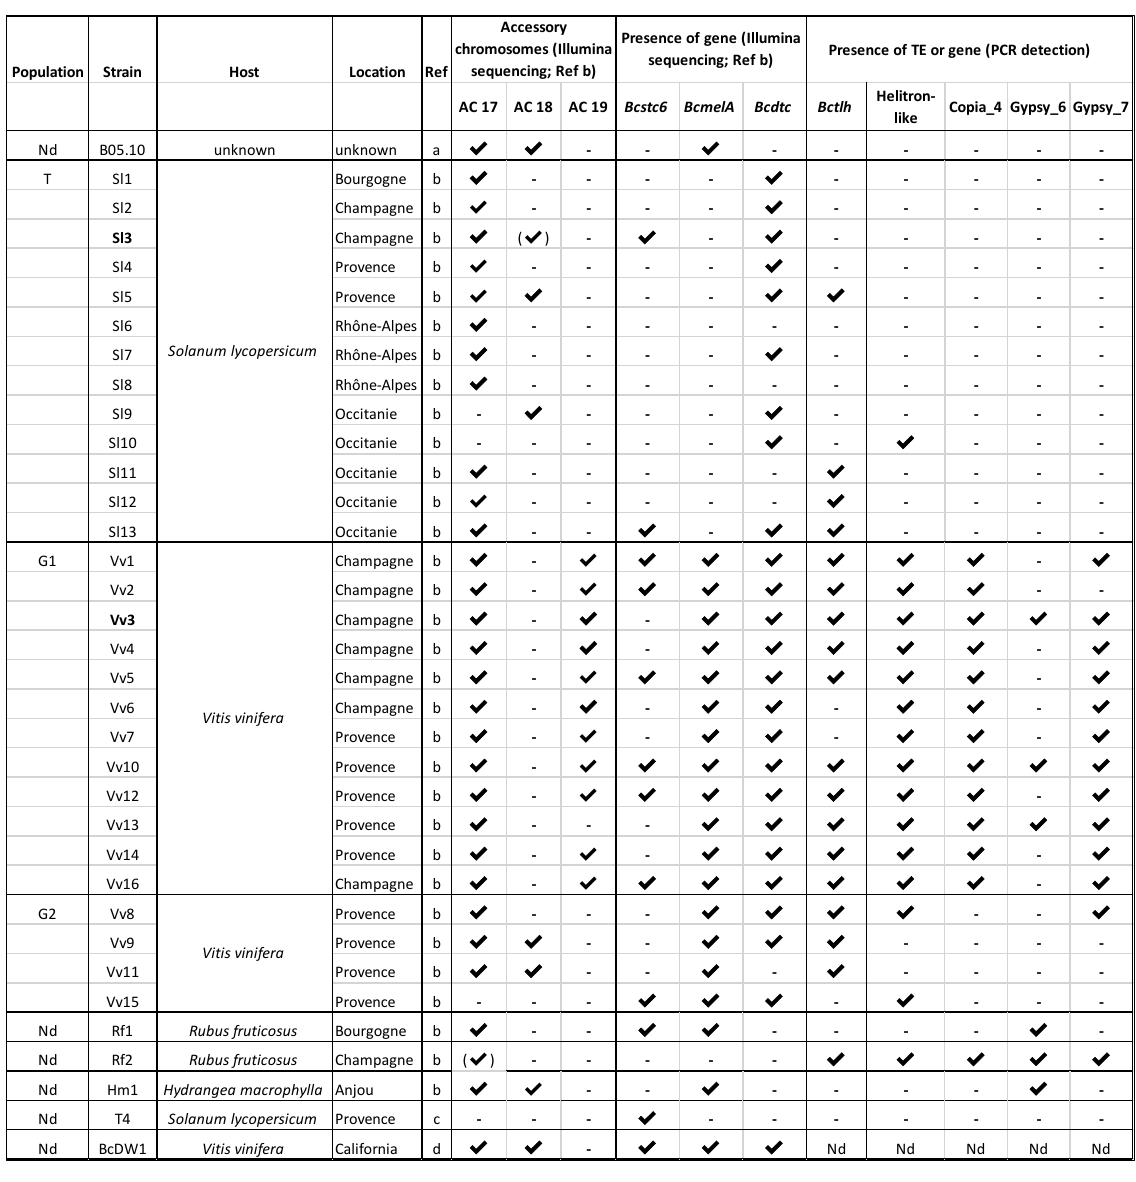
Table 1 : Distribution of Accessory Chromosomes (ACs) and a selection of dispensable genes and Transposable Elements (TEs) in B. cinerea strains from different populations. The genomic features highlighted in the present study, using complete assemblies of Sl3 and Vv3 genomes, were investigated in populations specialized either on grapevine (G1 and G2) either on tomato (T; Mercier et al., 2021). The distribution of ACs and secondary metabolism key genes were investigated using Illumina genomic data (Mercier et al., 2021) while those of the TEs and of the gene encoding the telomere-linked helicase (BcHTL) were investigated by PCR. a. van Kan et al., 2017. b. Mercier et al., 2021. c. Amselem et al., 2011. d. Blanco-Ulate et al., 2013. Nd, not determined. , presence. -, absence. ( ), partial presence of an AC. ✔ ✔ Nd, Not